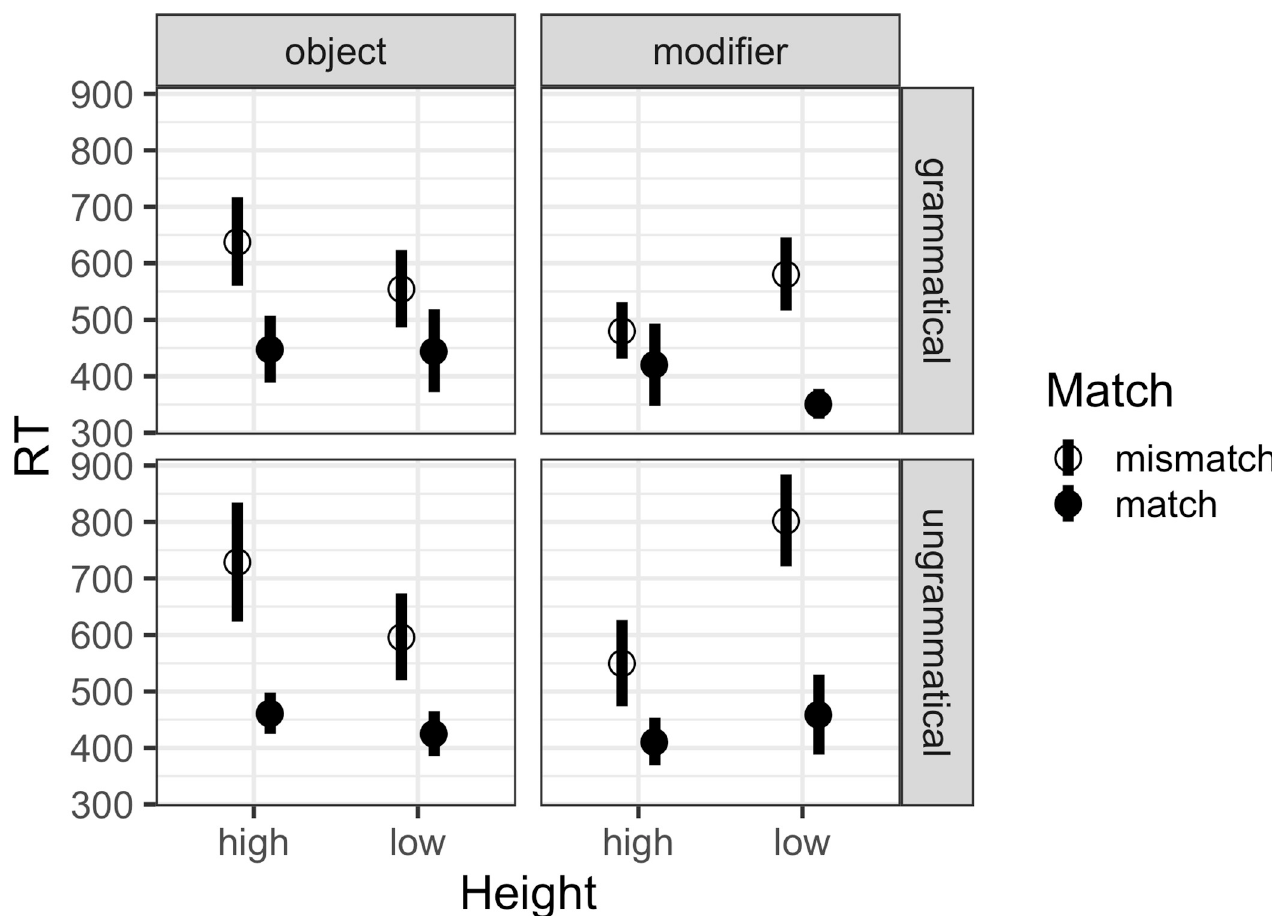
Fig 1. Mean judgment RTs in Experiment 1. Error bars report standard error over